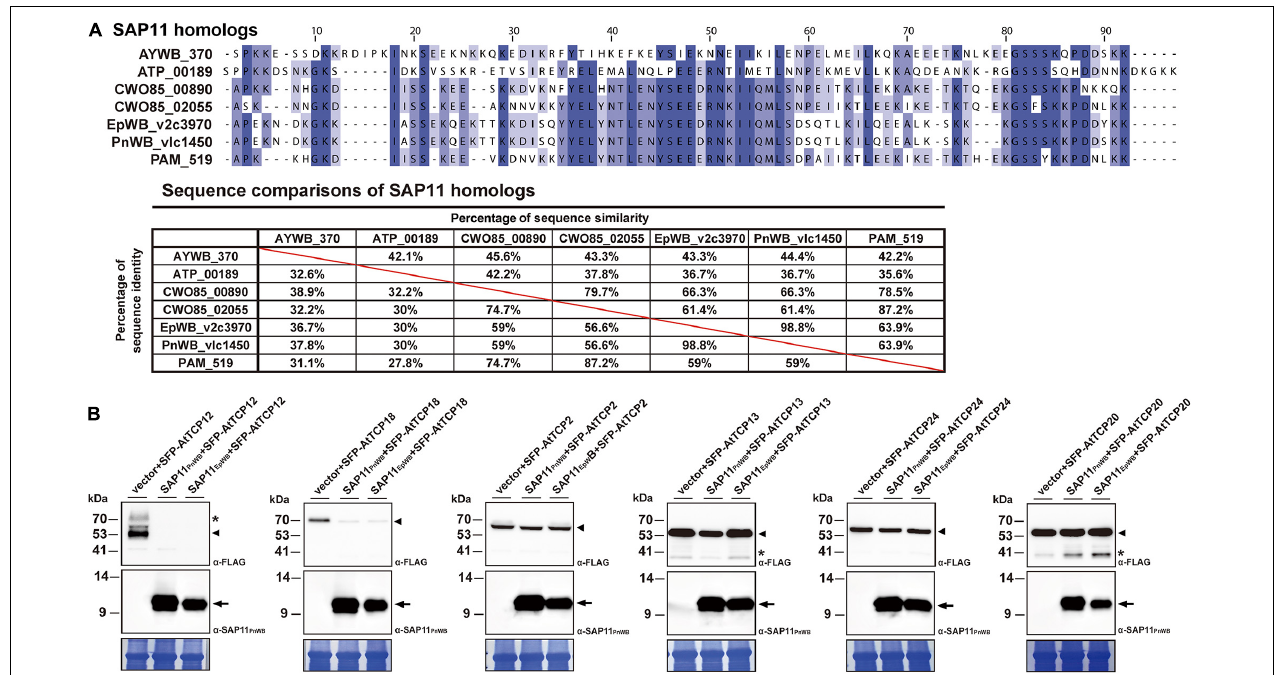
FIGURE 8 | Destabilization of Arabidopsis CYC/TB1-TCPs transcription factors by SAP11 of ‘ Ca . P. aurantifolia’ NCHU2014. (A) Sequence comparison of SAP11 homologs identified in ‘ Ca . P. asteris’ AYWB (AYWB_370), ‘ Ca . P. mali’ AT (ATP_00189), ‘ Ca . P. ziziphi’ Jwb-nky (CWO85_00890), ‘ Ca . P. ziziphi’ Jwb-nky (CWO85_02055), ‘ Ca . P. aurantifoli’ NCHU2014 (EpWB_v2c3970), ‘ Ca . P. aurantifolia’ NTU2011 (PnWB_v1c1450), and ‘ Ca . P. asteris’ OY-M (PAM_519). SAP11 homologs without the signal peptide were aligned by MEGA 7.0 using ClustalW. The sequence alignment was then edited by Jalview software in which identical residues are shaded in blue (upper panel). The color gradient indicates the level of sequence conservation at each position. The sequence identity and sequence similarity between SAP11 homologs are presented on the lower panel. (B) After transient co-expression in N. benthamiana , the relative abundance levels of FLAG-tagged PCF-TCP (AtTCP20), CIN-TCPs (AtTCP2, AtTCP13, and AtTCP24), and CYC/TB1-TCPs (AtTCP12 and AtTCP18) were examined in the presence of SAP11 effectors through Western blotting. Monoclonal antibody against the FLAG-tagged TCPs (upper panel) and polyclonal antibody against SAP11 effectors (middle panel) were used. As a loading control, the large subunit of Rubisco was visualized with Coomassie Brilliant Blue staining (lower panel). Non-specific bandings recognized by antibodies are indicated by